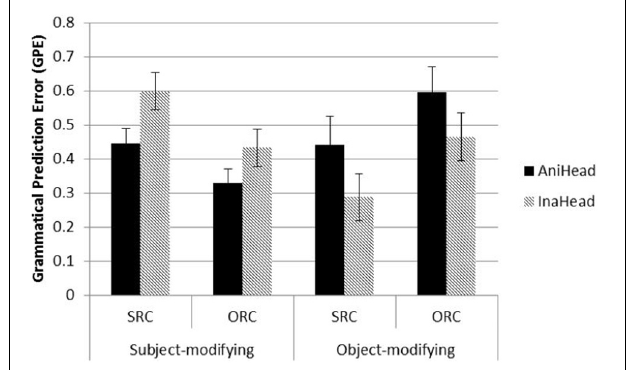
FIGURE 5 | GPEs of SRCs and ORCs at the head noun. AniHead = animate head noun, InaHead = inanimate head